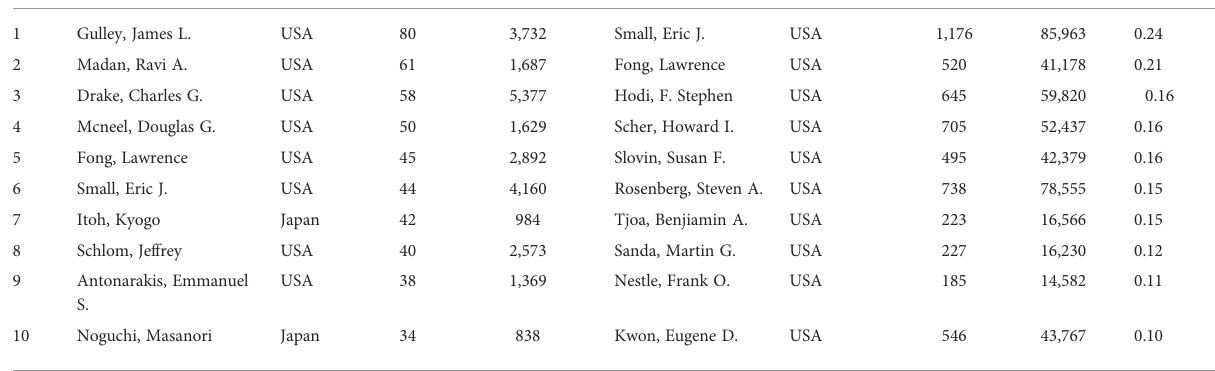
TABLE 2 The 10 most productive authors and the top 10 co-cited authors with the highest centrality. Rank Author Gulley, James